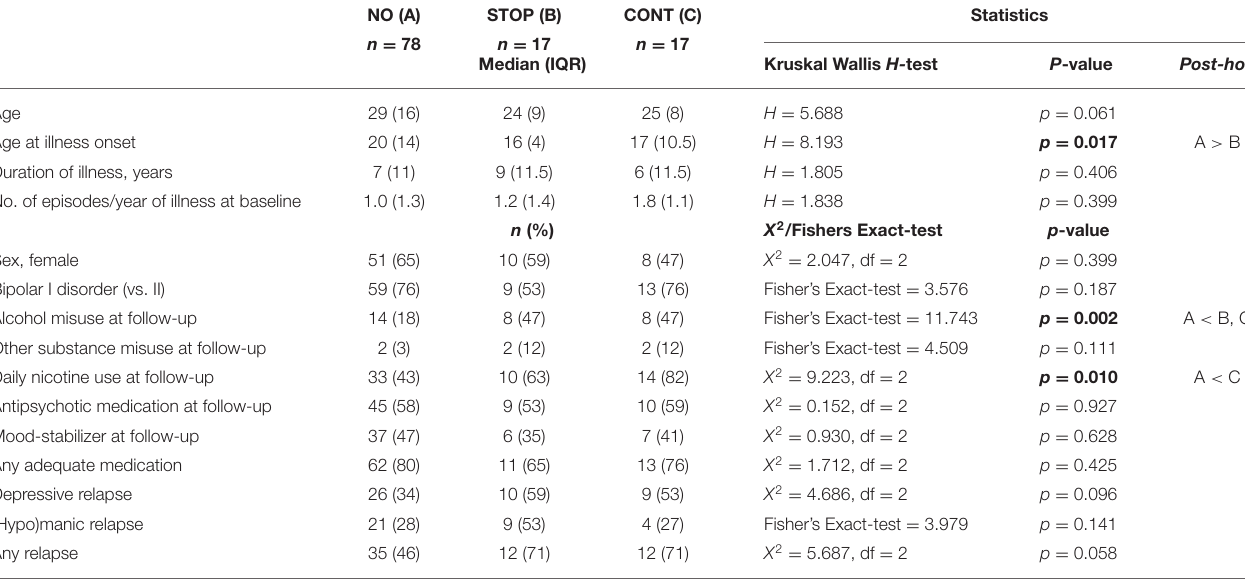
TABLE 2 | Sociodemographic and clinical characteristics across cannabis misuse trajectories.